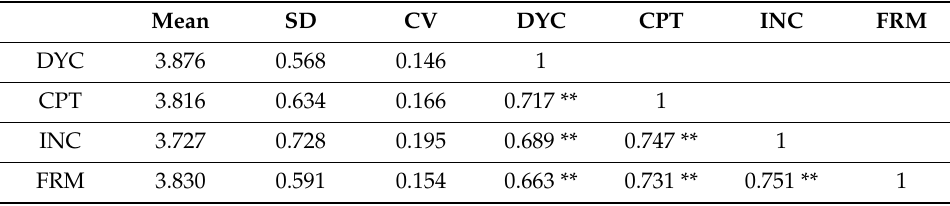
Table 3. Descriptive statistics and correlation.